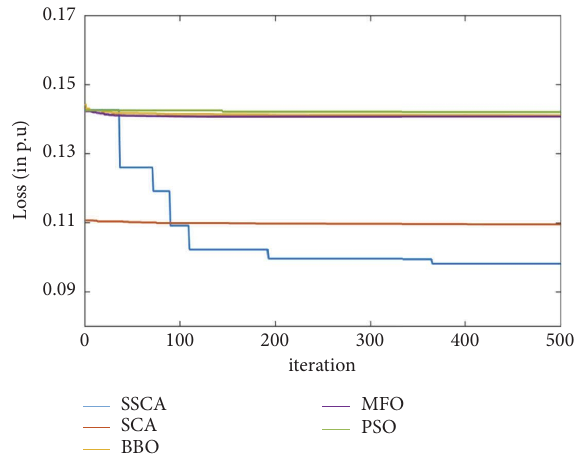
Figure 4: Loss variation in the IEEE 30 bus system at 125%